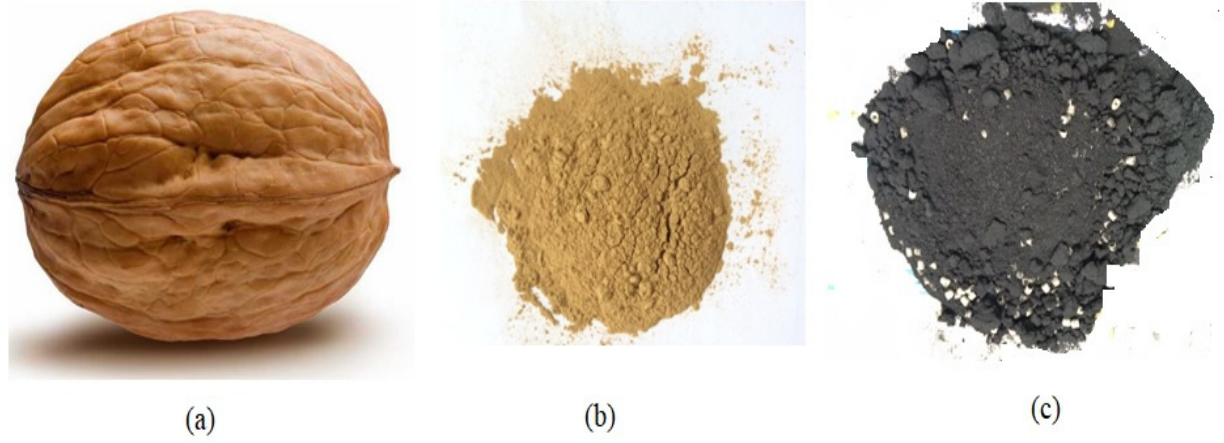
Figure 2. ( a ) The original shape of walnut ( b ) shell residues and ( c ) their respective